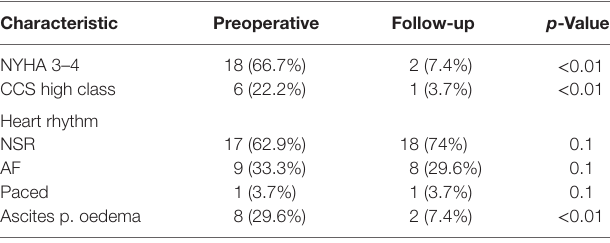
TaBle 4 | clinical and functional assessment of patients with isolated tricuspid repair ( n = 27).